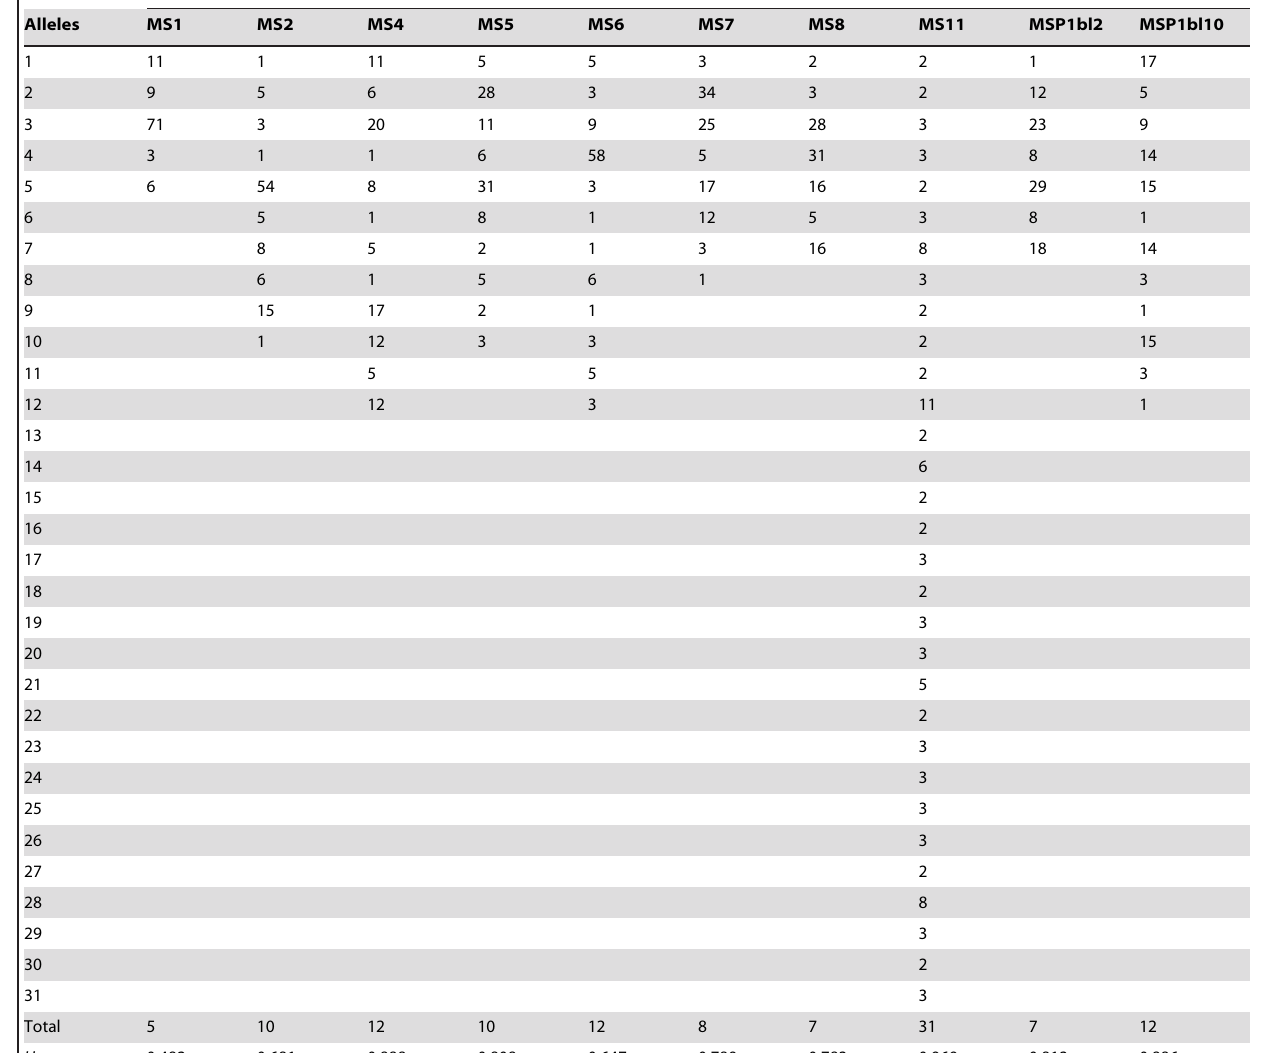
Percentage of episodes